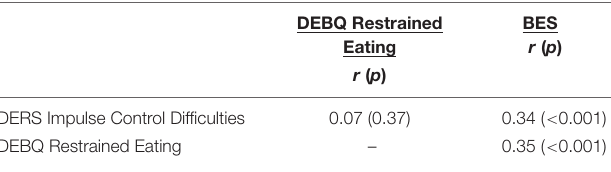
TABLE 2 | Correlations between impulse control difficulties, restrained eating, and binge eating severity in under- and normal-weight respondents.